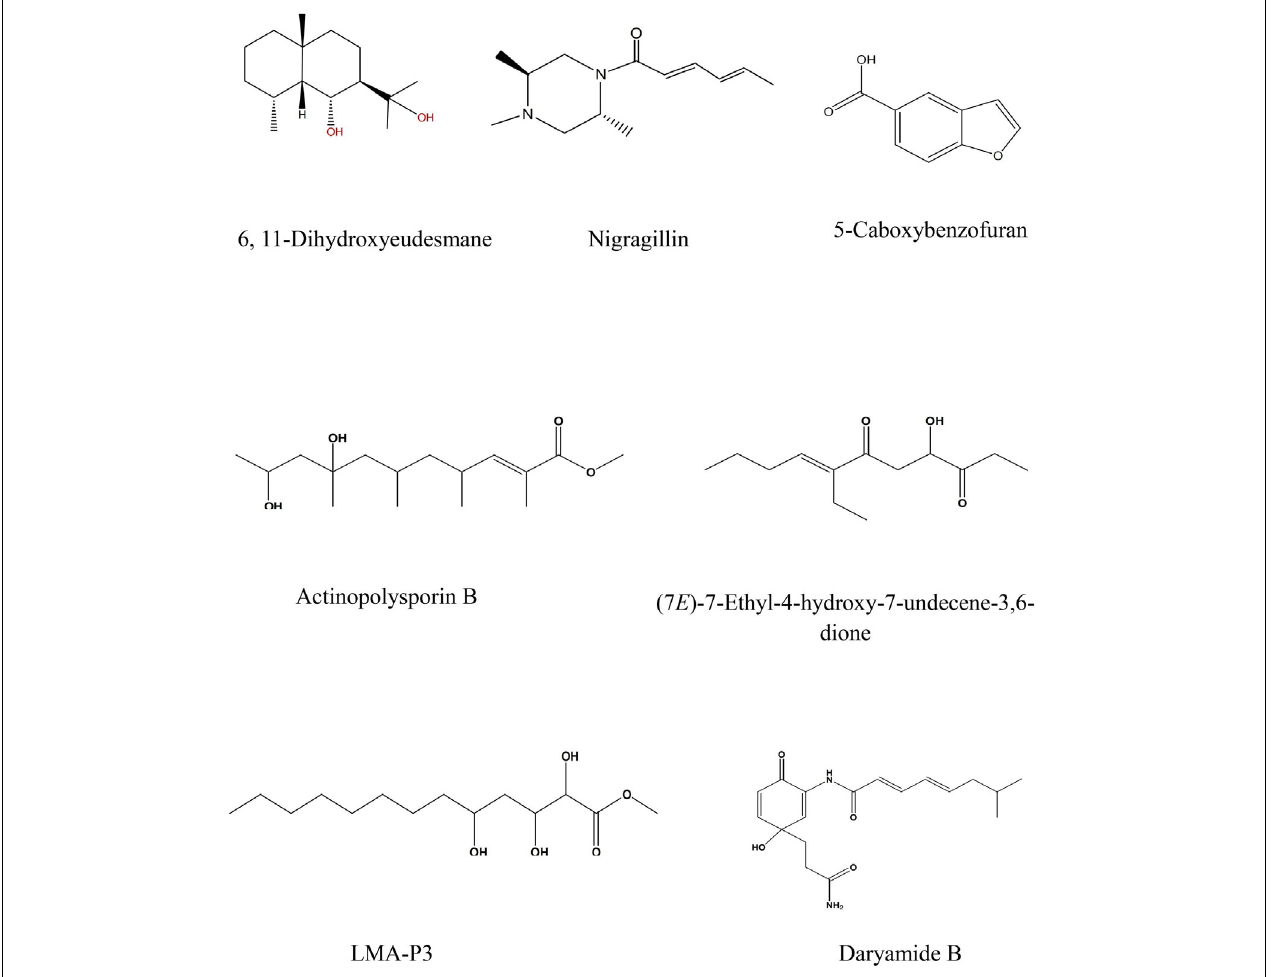
FIGURE 4 | Selected structures of predicted chemical formulas from LC-HRESIMS analysis for the isolated microorganisms.